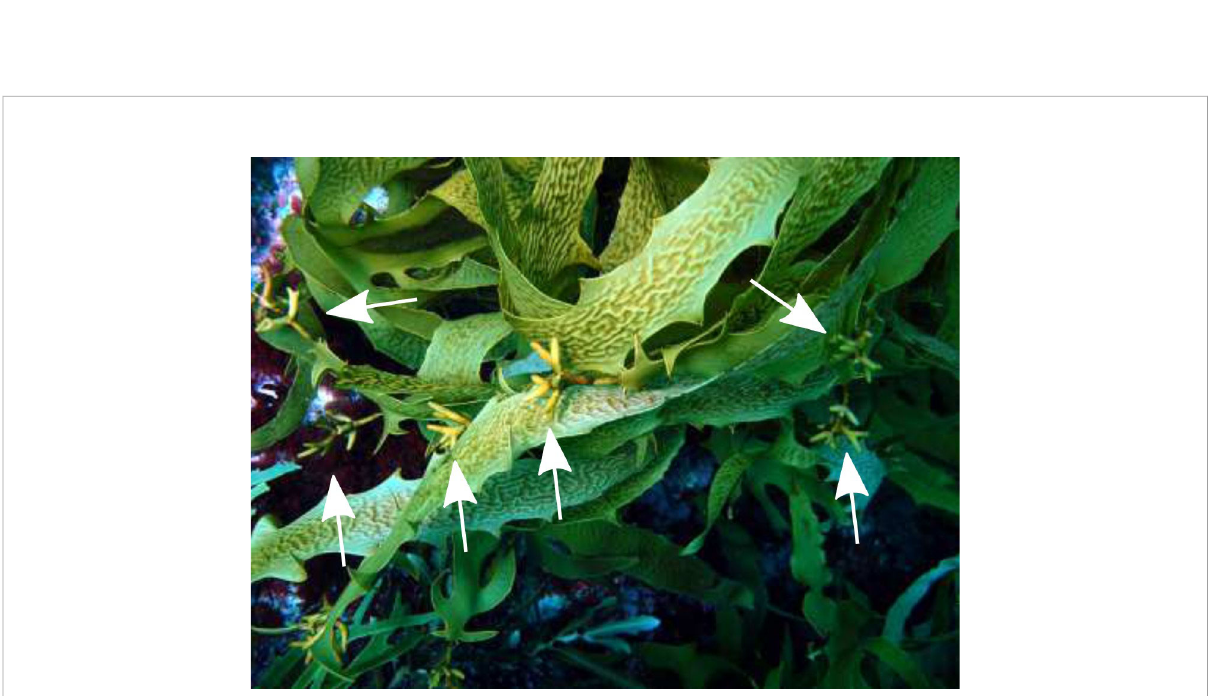
FIGURE 2 Ecklonia radiata from Hamelin Bay, Western Australia. The ‘ normal ’ haplodiplontic morph and the unique clonal morph with haptera at the end of every lateral (white arrow) grow interspersed on the same reef. Picture by